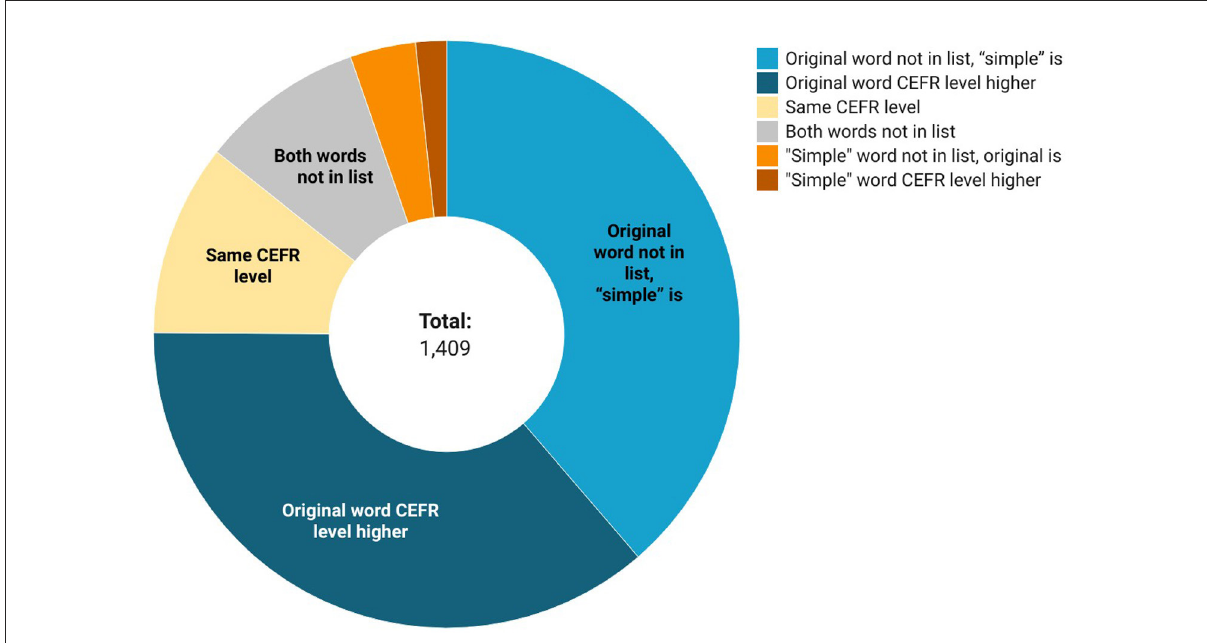
FIGURE2 Word grade levels